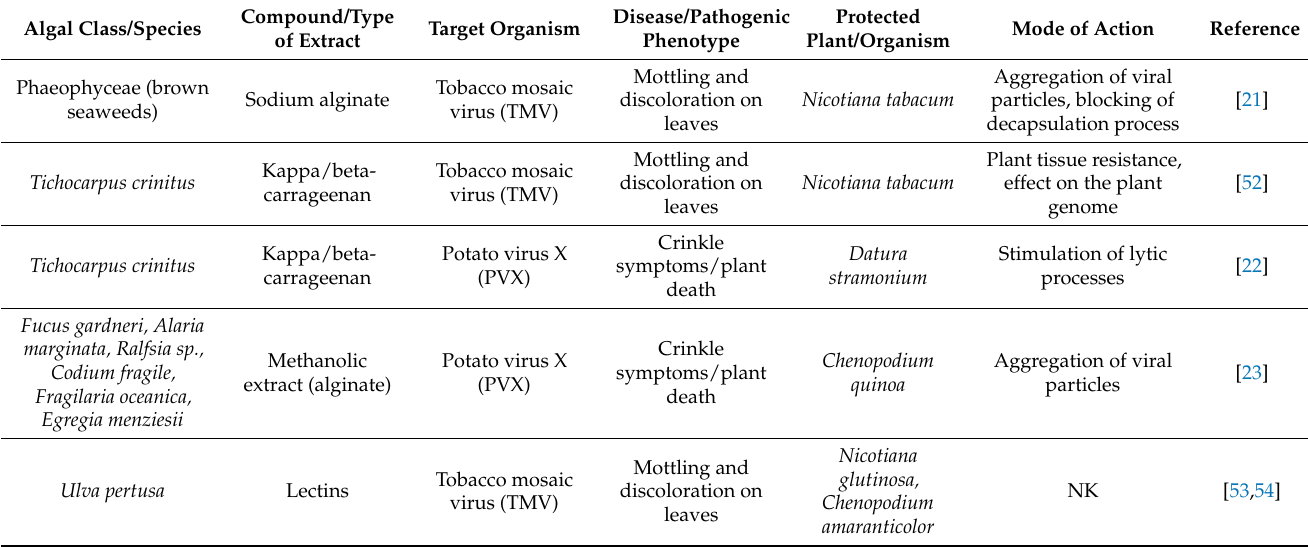
Table 2. Summary of the antiviral activities of algal compounds against plant pathogens.